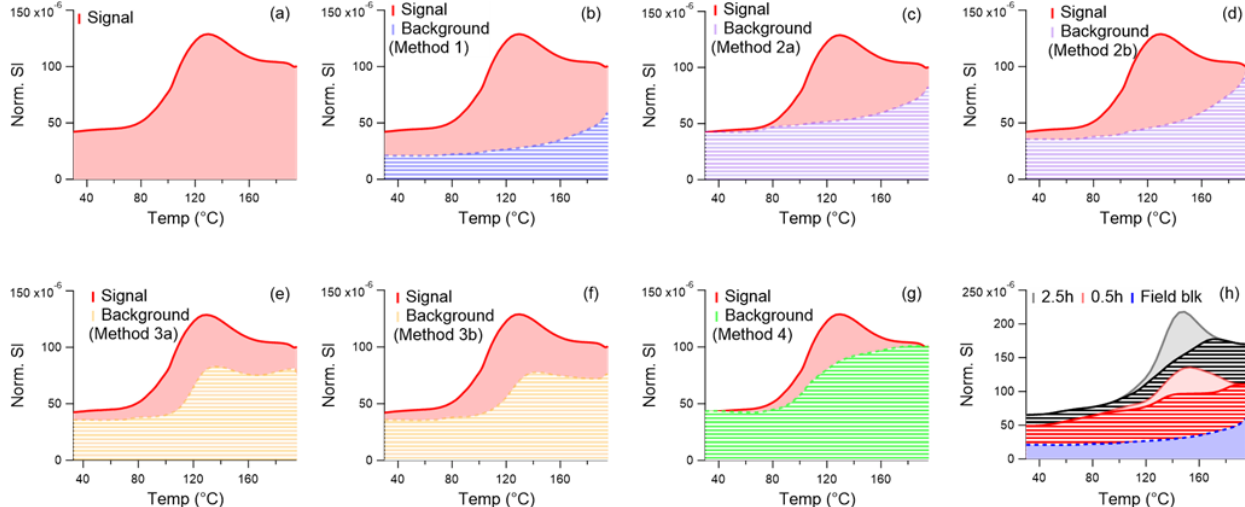
Figure 2. Schematic of a compound’s signal and background thermograms for different background determination methods. The x axis is the temperature during ramping, and the y axis is the signal intensity normalized by the primary ion (I − ). (a) Total sample signal of a model compound without blank subtraction, (b) Method 1 is the field blank only, (c) Method 2a is the scaling field blank to the start of ramping, (d) Method 2b is the scaling field blank to the end of soaking, and (e) Method 3a is the reheating of a subset of filters and using the average signal ratio from reheated and heated filters as background signal for all filters (individual compound based). (f) Method 3b is the reheating of a subset of filters and using an exponential fit to the entire mass range of the average signal ratio from reheated and heated filters as background signal for all filters. (g) Method 4 is the thermal baseline using a spline algorithm. (h) One 0.5h and one 2.5h sample with blank subtraction. Ideally, the Is of the 2.5h collection sample (Is 2 . 5h ) would be close to the sum of the five paralleled 0.5h collection samples (Is 0 . 5h